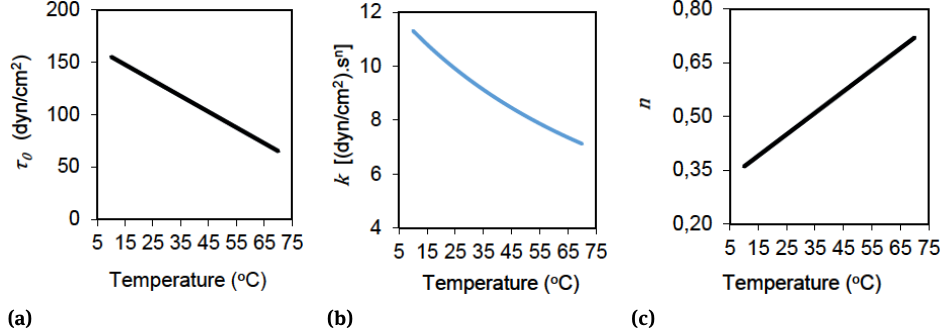
Figure 7: Trends of a) τ 0 , yield stress b) k, consistency coeflcient and c) n, flow index, in the temperature range of 10-70 ∘